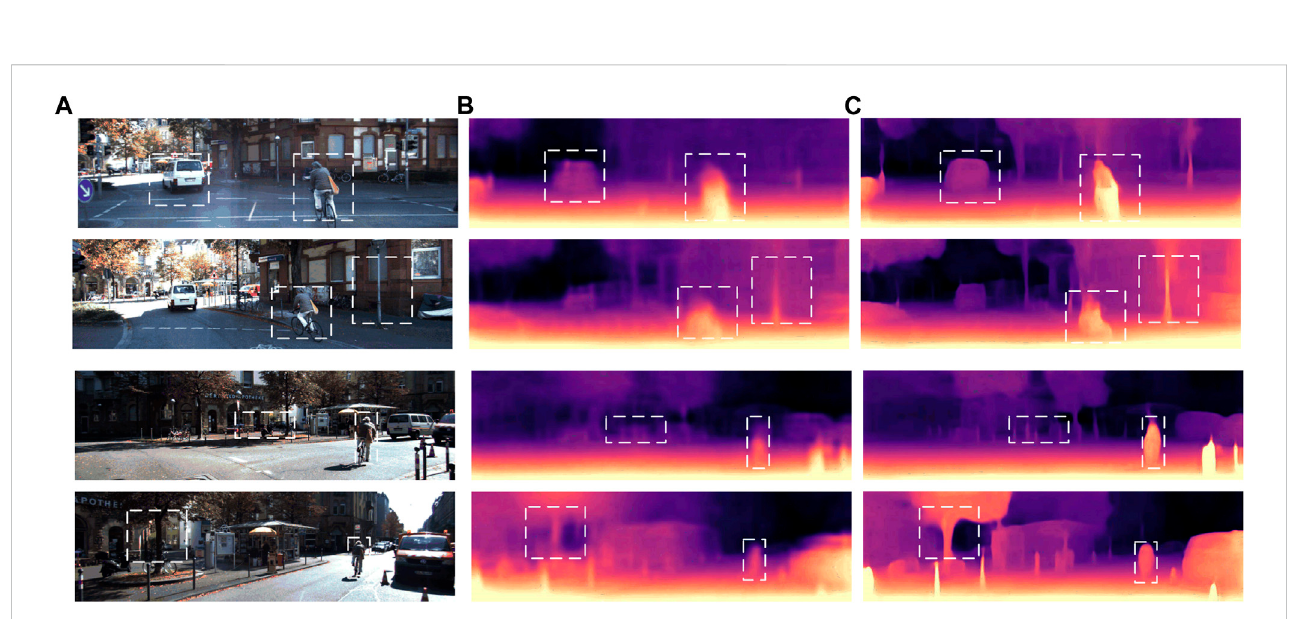
FIGURE 11 Comparative experimental results of attention mechanism SE module visualization on KITTI dataset: (A) The color image input by the model; (B) The depth map results predicted by Zhou et al.; (C) The depth map predicted by SEResNet50 embedded attention mechanism in the pose estimation network.